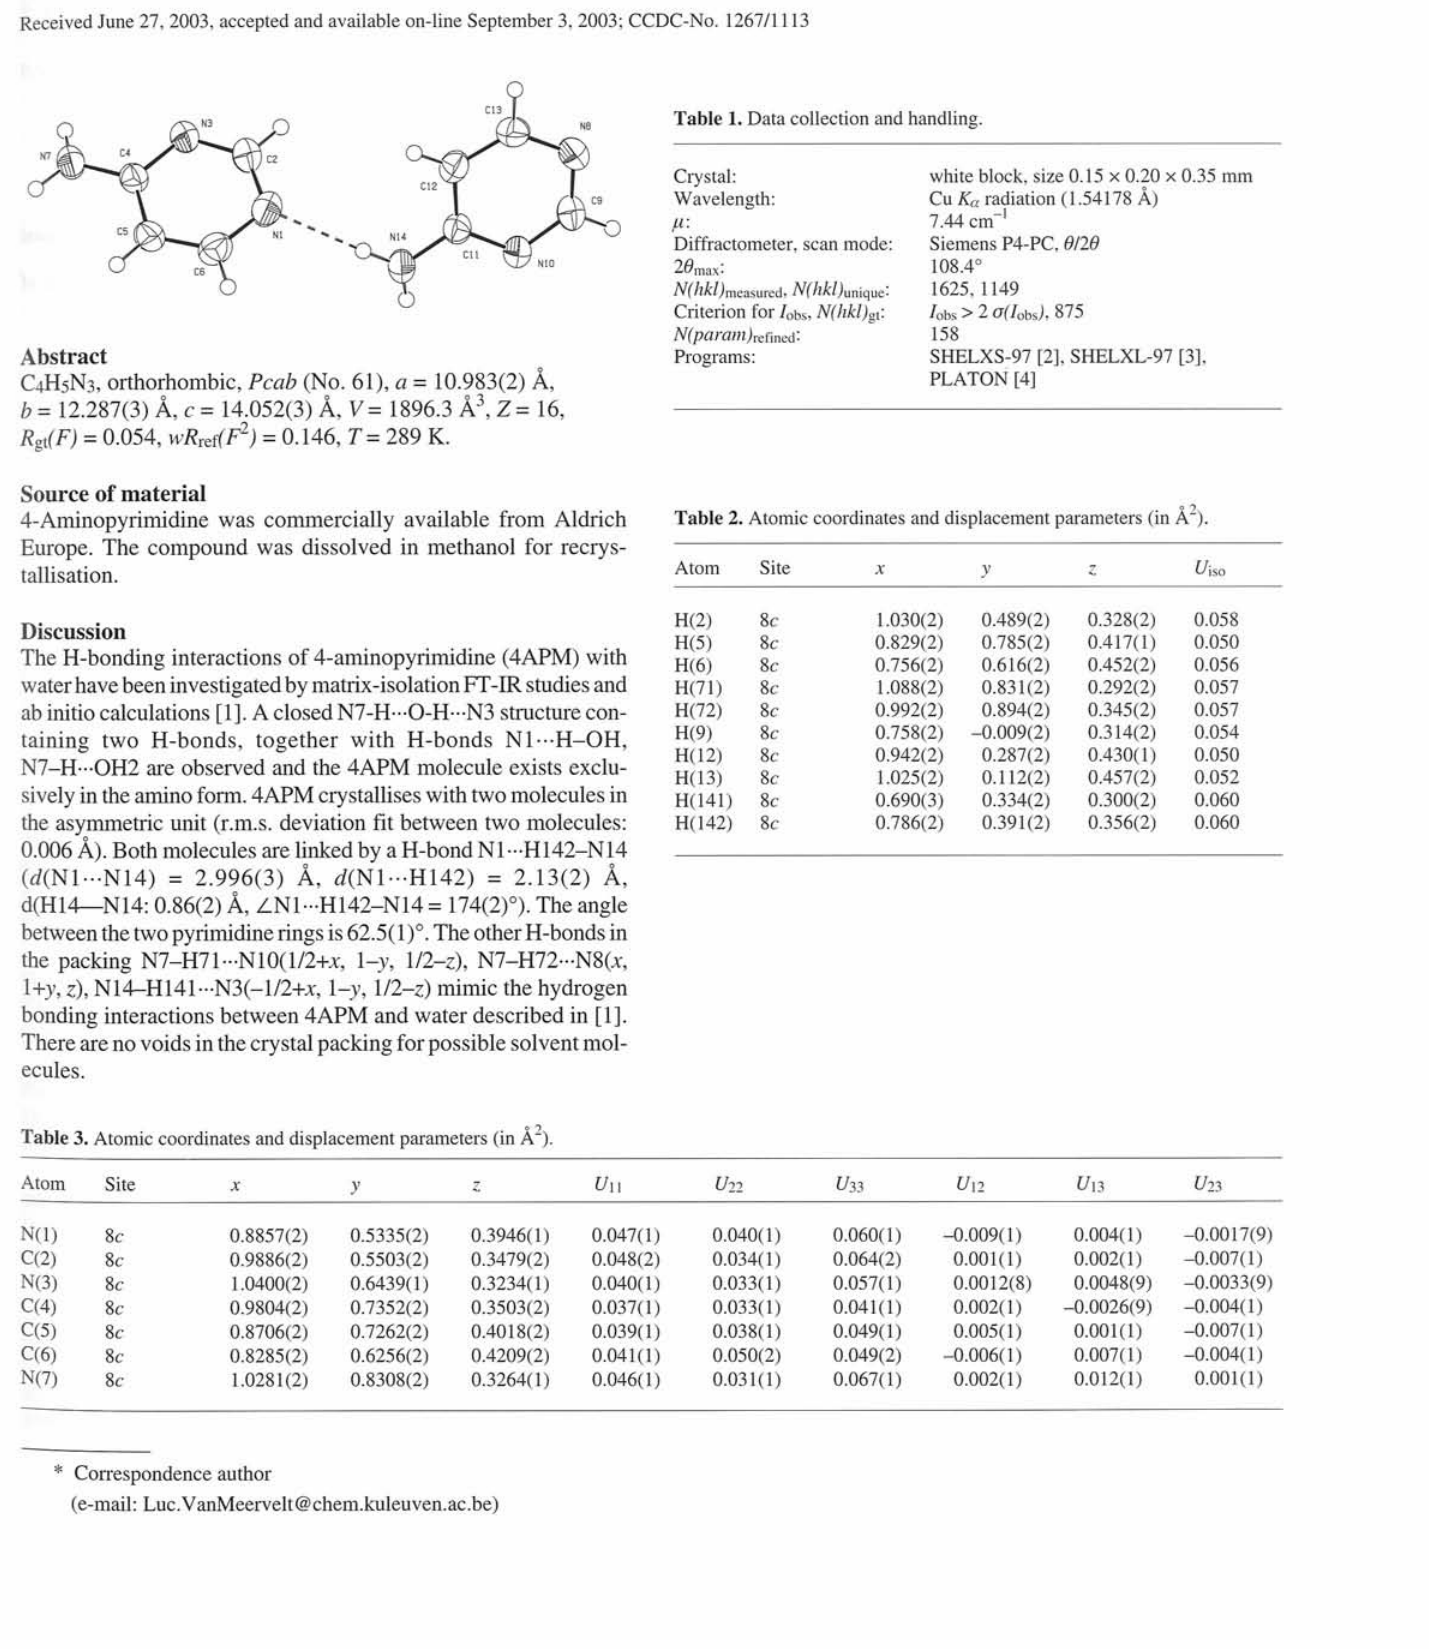
Table 1. Data collection and handling.